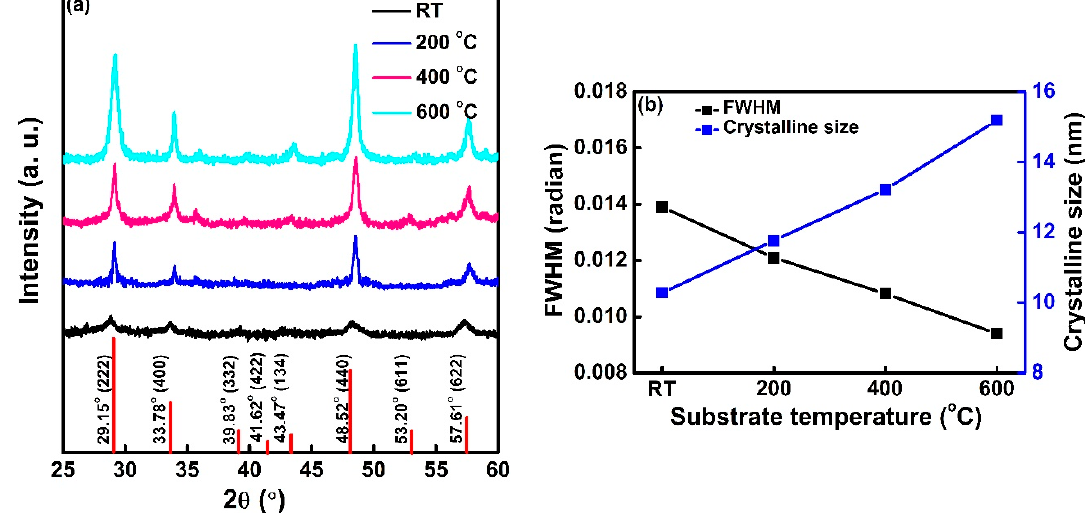
Figure 1. ( a ) XRD scans of the Y 2 O 3 films grown at different substrate temperatures and ( b ) effect of substrate temperature on the average crystallite size and full width at half maximum (FWHM).